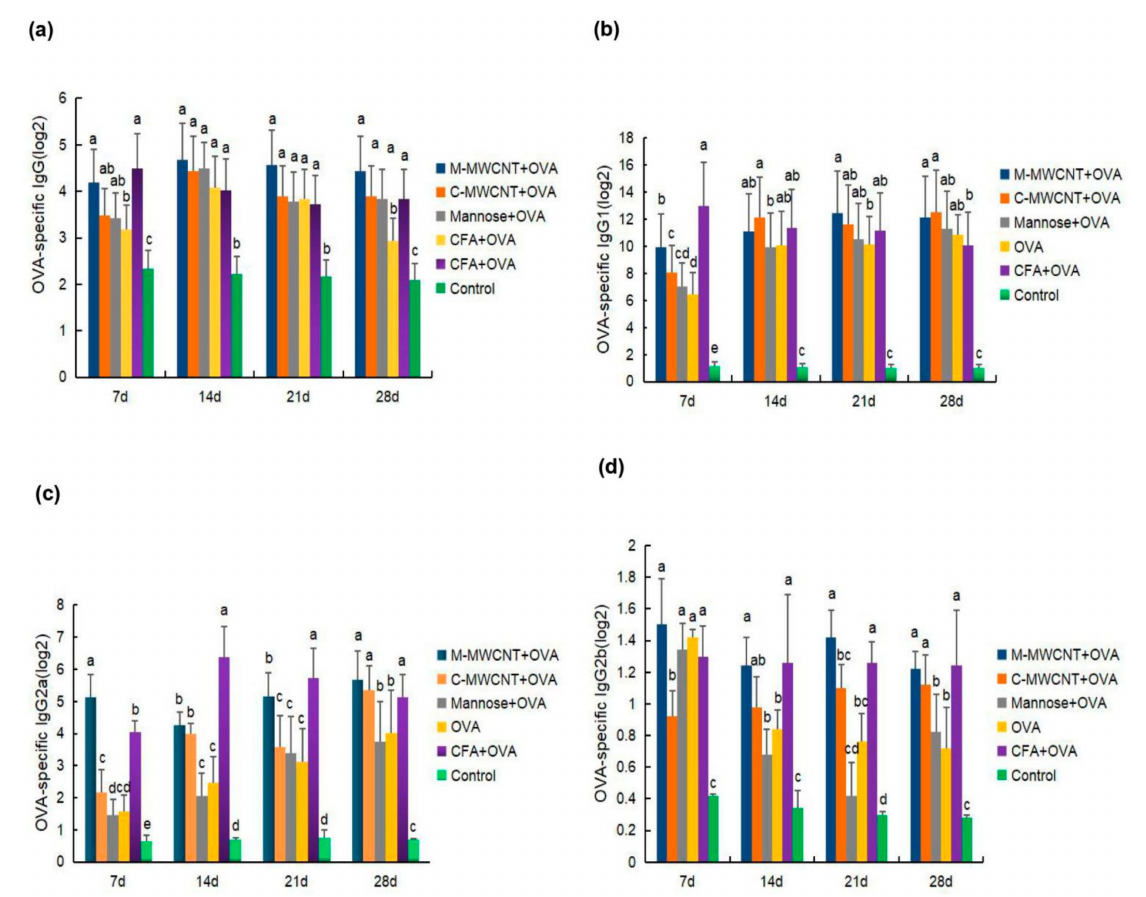
Figure 9. Effects of M-MWCNT on serum levels of IgG ( a ), IgG1 ( b ), IgG2a ( c ), and IgG2b ( d ) in ICR mice. Serum samples of ICR mice collected on days 7, 14, 21, 28 after the first immunization were analyzed by ELISA. The data are presented as the mean ± SD ( n = 3) analyzed by one-way ANOVA and then Duncan’s multiple-range tests. Different letters (a, b, c, and d) above each group of bars indicate statistically significant differences ( p <